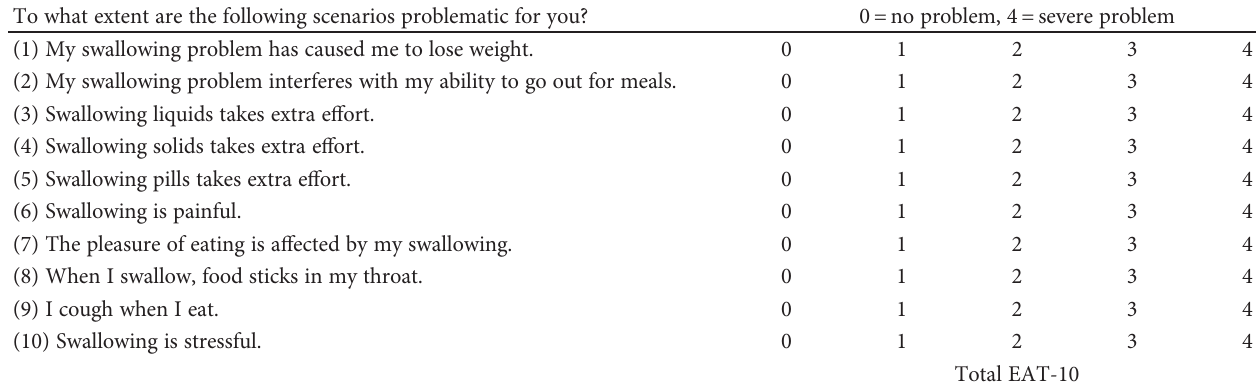
Table 1: Eating Assessment Tool (EAT-10)